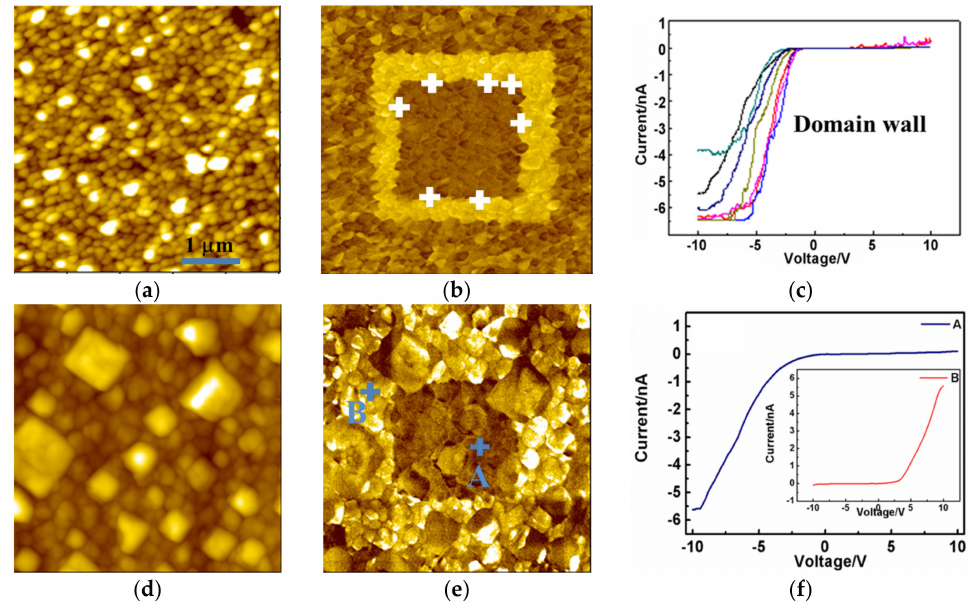
Figure 2. Topography images of BiFe 0.95 Mn 0.05 O 3 (BFMO) films with the deposition at oxygen pressures of ( a ) 2 Pa and ( d ) 10 Pa respectively, with the ( b , e ) corresponding piezoresponse force microscopy (PFM) phase images and the ( c , f ) I–V curves of BFMO